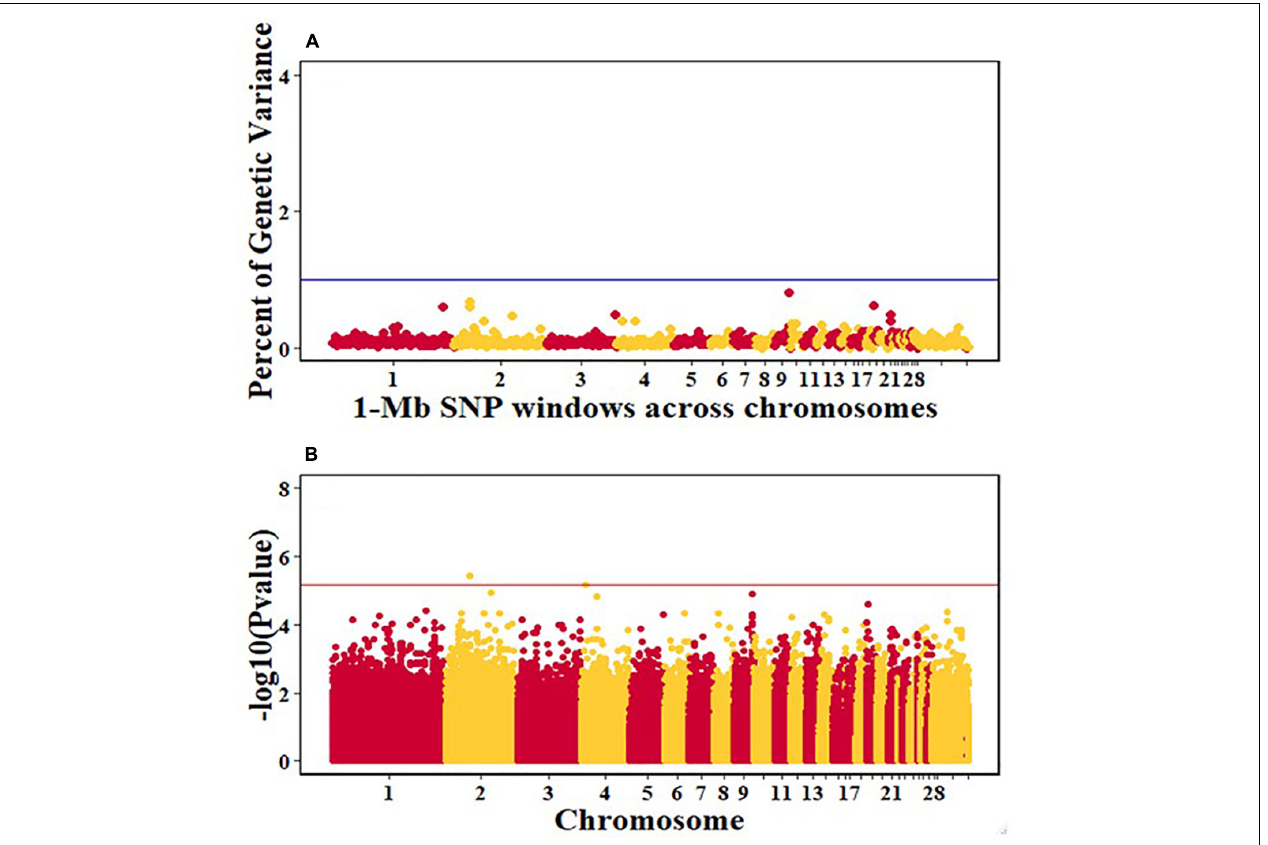
FIGURE 8 | Manhattan plots showing the genome-wide association results for viral clearance in the Ghana local chicken ecotypes population, using Bayes-B and single-SNP analyses. (A) Bayes-B results showing the percent of genetic variance explained by SNPs in 1-Mb non-overlapping windows across chromosomes. (B) Single-SNP results showing the -log10(Pvalue) of ordered SNPs across the chromosomes. The blue and red lines indicate genome-wide significance at 1% genetic variance and 20% genome-wide suggestive association,